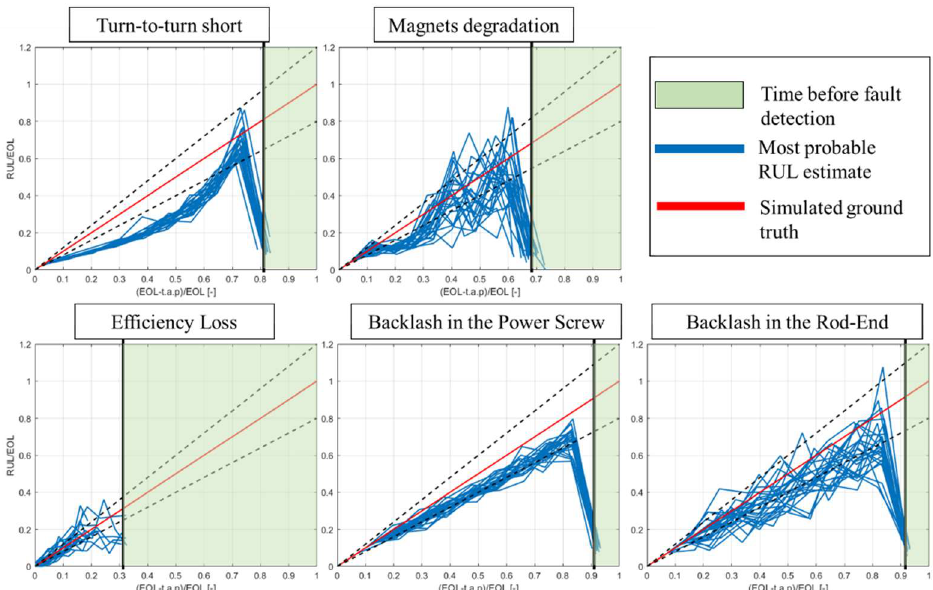
Figure 23. Elapsed time breakdown—average execution time of a particle-filtering step.